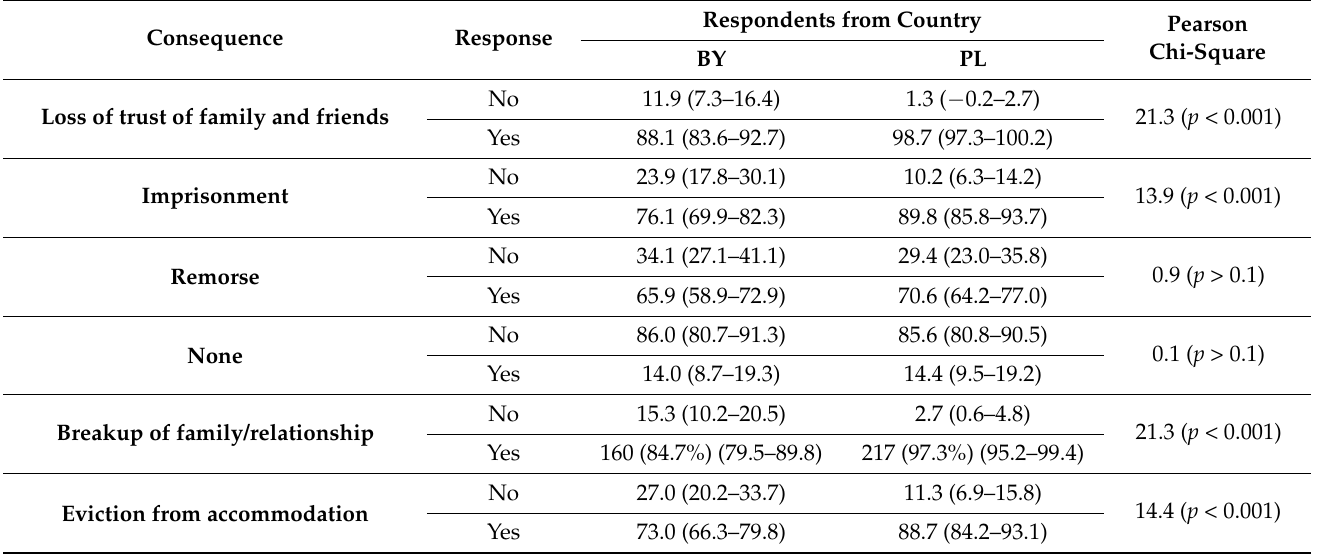
Table 4. Consequences for perpetrators of domestic violence in the perceptions of students from Poland and